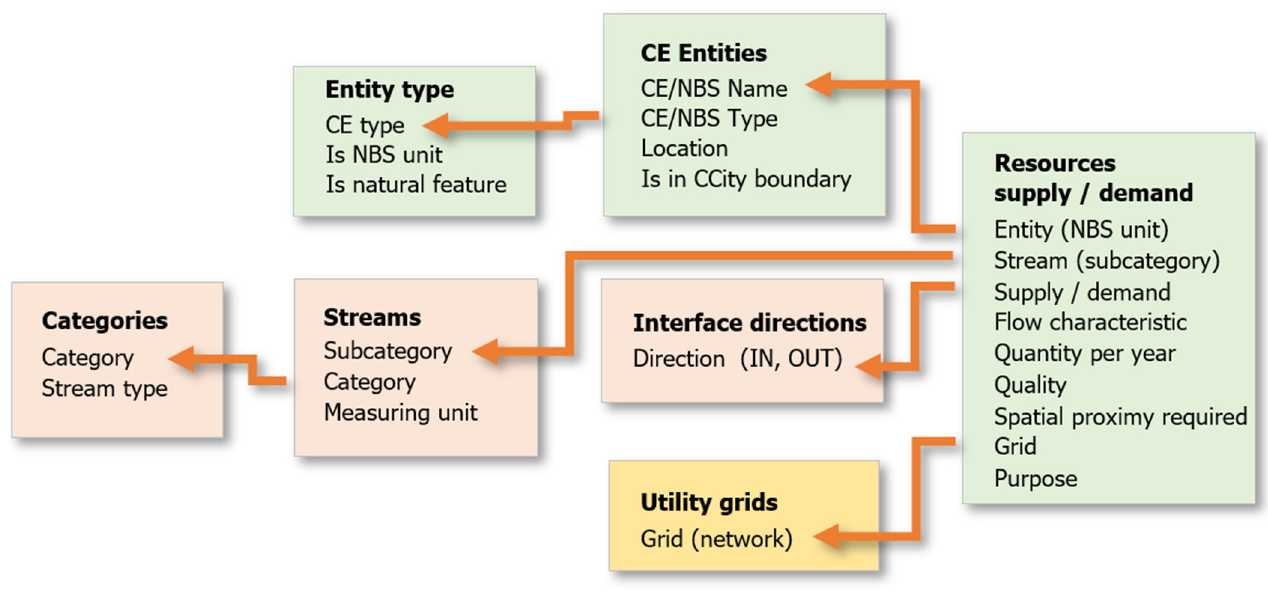
Figure 7. An information model on NBS_u/i and interconnecting streams (Figure 1). Green: entities and their resources; red: streams; yellow: grids (optional).